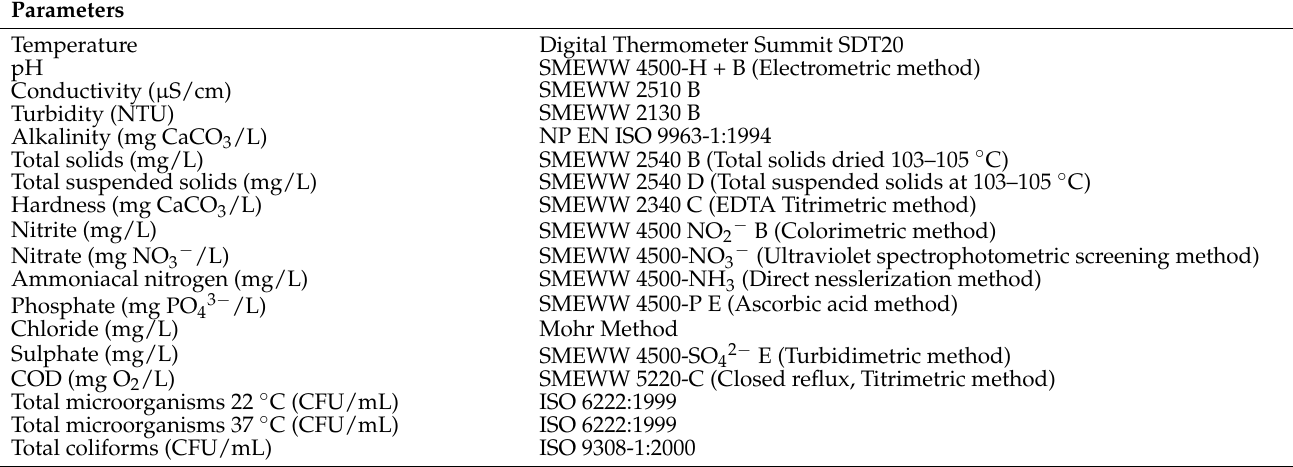
Table A1. Rainwater parameters determined and analytical methodology. Parameters